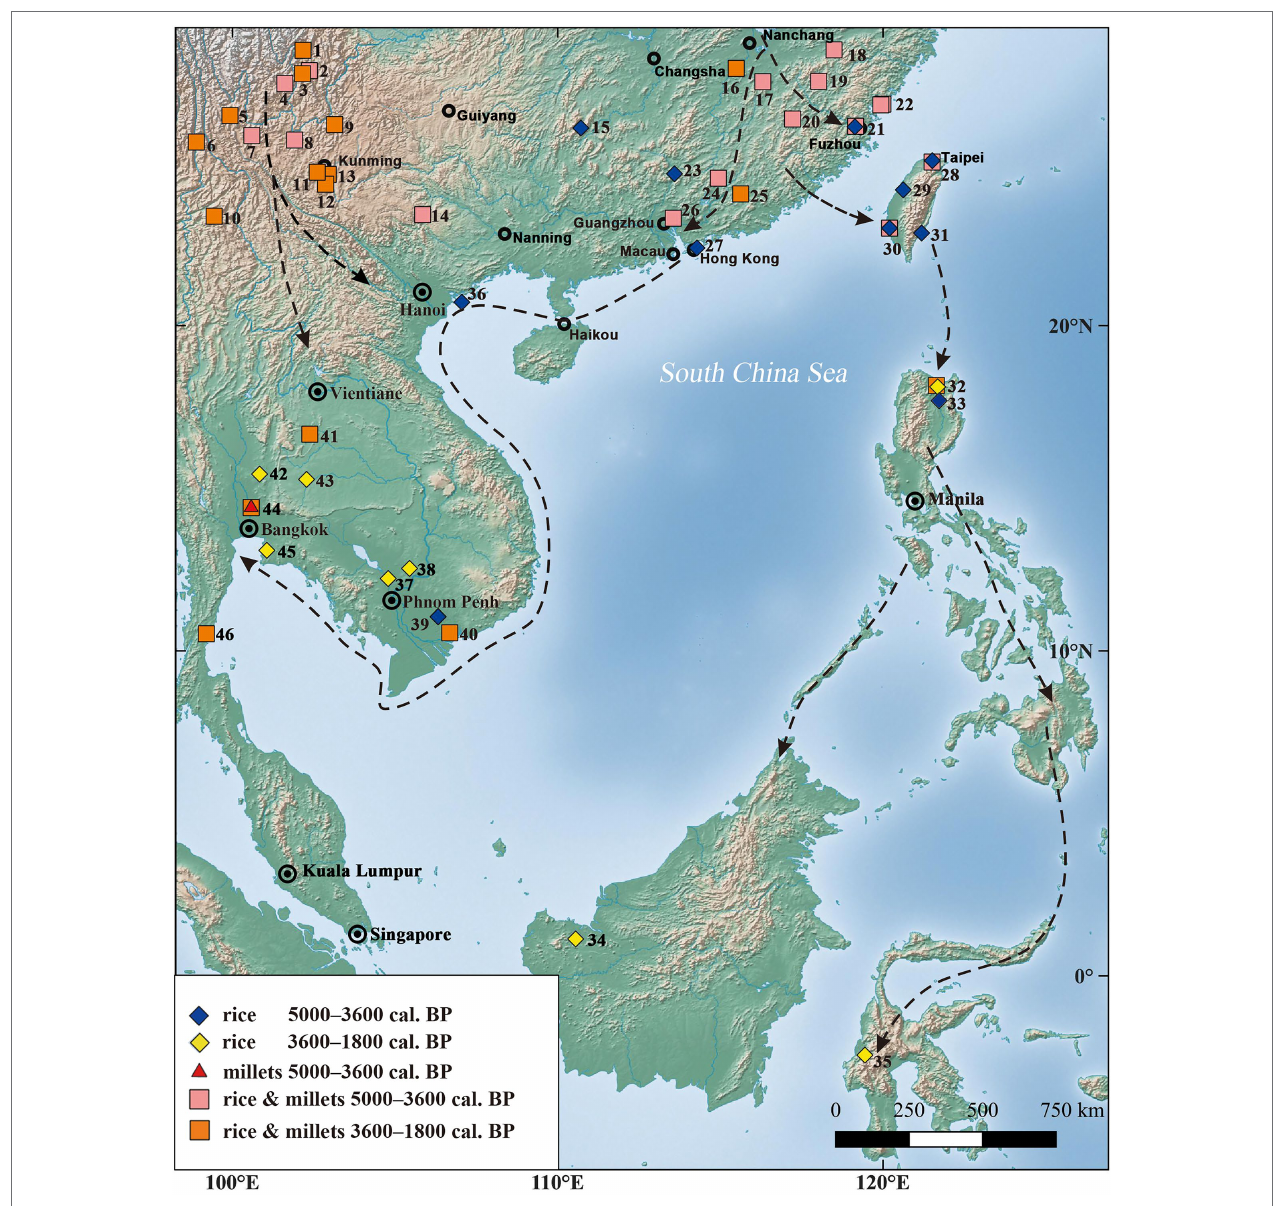
FIGURE 10 | Distribution of major sites with rice and/or millets in Southern China and Southeast Asia, and related agriculture dispersal routes; (1) Gaopo, (2) Henglanshan, (3) Shapingzhan, (4) Guijiabao, (5) Haimenkou, (6) Shilinggang, (7) Baiyangcun, (8) Dadunzi, (9) Yubeidi, (10) Shifodong, (11) Heposuo, (12) Guangfentou, (13) Xueshan, (14) Gantuoyan, (15) Xiaojin, (16) Niucheng, (17) Guodishan, (18) Shanyawei, (19) Hulushan, (20) Nanshan, (21) Zhuangbianshan and Baitoushan, (22) Pingfengshan and Huangguashan, (23) Shixia, (24) Laoyuan, (25) Shixiongshan, (26) Gancaoling, (27) Shaha, (28) Zhiwuyuan (rice and foxtail millet) and Dalongdong (only rice), (29) Anhe, (30) Nanguanlidong and Youxianfang (rice and millets) and Nanguanli and Sanbaozhunan (only rice), (31) Chaolaiqiao, (32) Nagsabaran and Magapit, (33) Andarayan, (34) Gua Sireh, (35) Minanga Sipakko, (36) Cai Beo, (37) Samrong Sen, (38) Krek 52/62, (39) An Son, Loc Giang, (40) Rach Nui, (41) Non Nok Tha, (42) Khok Charoen, (43) Ban Non Wat, (44) Non Pa Wai, Non Mak La, and Nil Kham Haeng, (45) Khok Phanom Di and Nong Nor, and (46) Khao Sam Kaeo (Details of all sites and references are listed in Supplementary Table S4